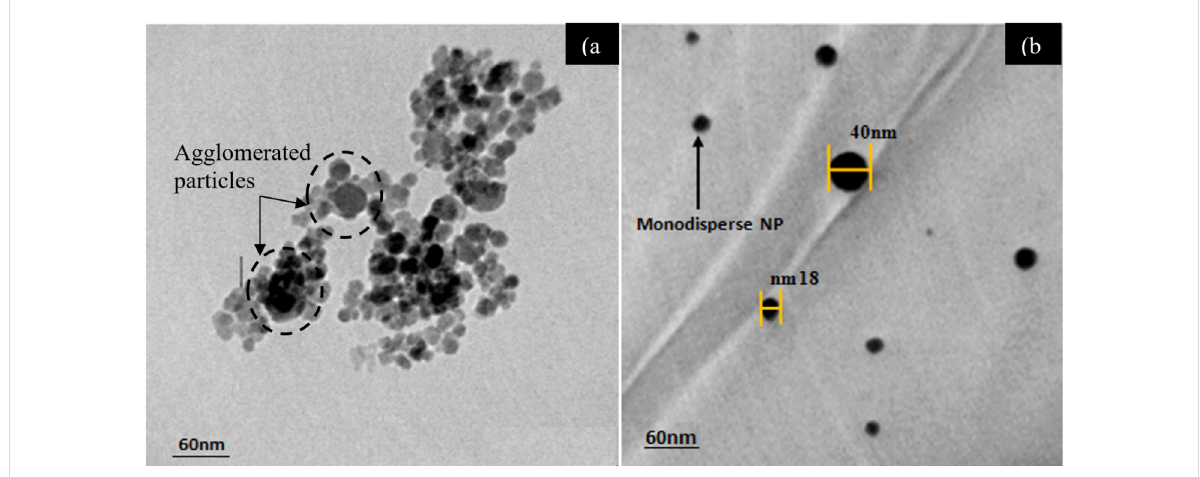
Figure 6: TEM images of Ag 2 S NPs synthesized (a) without CTAB and (b) with CTAB surfactant.